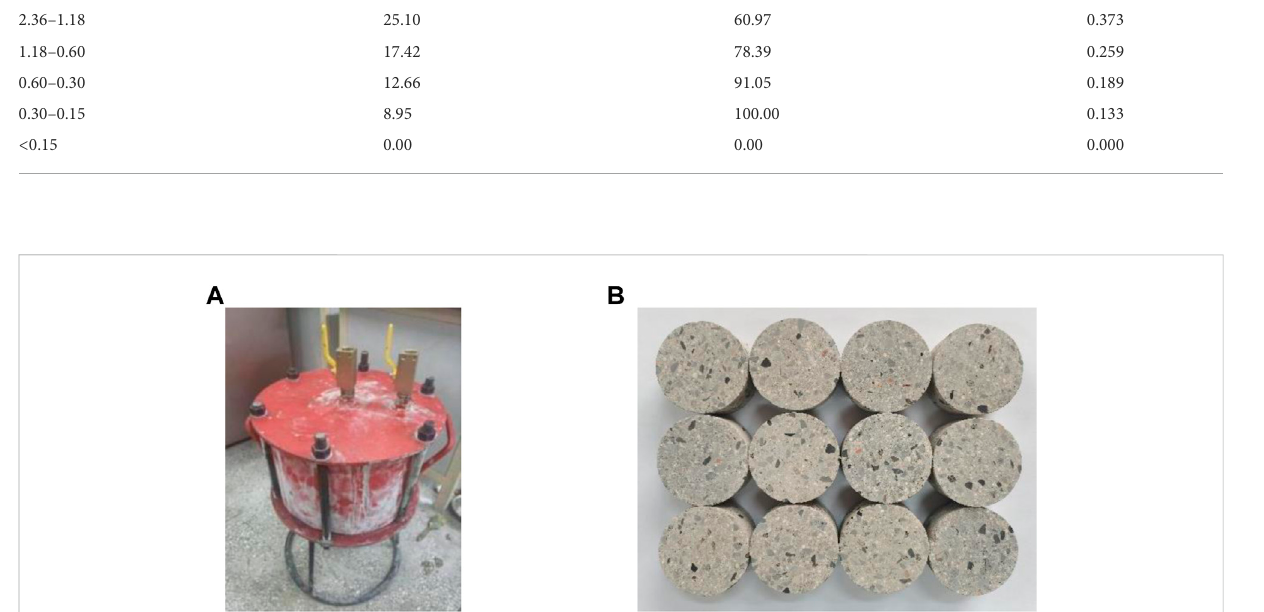
FIGURE 1 Grouting mold and specimens. (A) Grouting mould, (B) Grouting